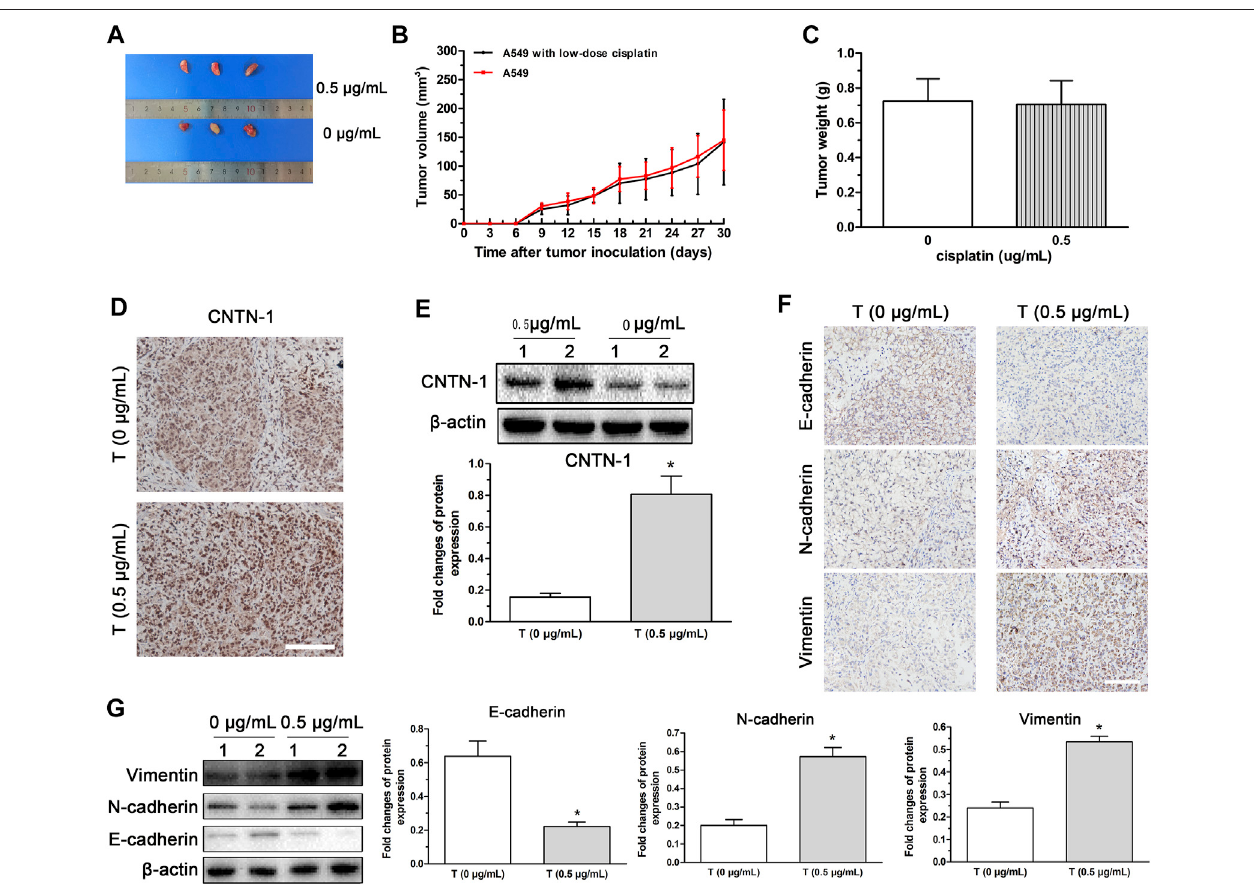
FIGURE6| CNTN -1upregulationandEMTprocessinducedinxenografttumorsdevelopedwithA549cellstreatedwithlow-dosecisplatin. (A) Tumorsdeveloped with A549 cells treated with low-dose cisplatin (0.5 g/mL) and without cisplatin (control), respectively. (B) Growth curves of tumors. No signi fi cant difference in volume was observed between tumors developed with A549 cells treated with low-dose cisplatin (0.5 g/mL) and controls. (C) Tumor weight. No signi fi cant difference of weight was observed between tumors developed by A549 cells treated with low-dose cisplatin (0.5 g/mL) and controls (* p > 0.05). (D – G) CNTN -1 and EMT-related markers(E-cadherin,N-cadherin,andvimentin)oftumorsmeasuredbyWesternblotandimmunohistochemistry,respectively.Both CNTN -1andmesenchymalmarkers (N-cadherin and vimentin) were signi fi cantly upregulated whereas epithelial marker (E-cadherin) was downregulated in the xenograft tumor developed by A549 cells treated with low-dose cisplatin compared with that of controls (* p < 0.05). All pictures were photographed at a magni fi cation of ×100, scale bar = 100 um. Each experiment was conducted in triplicate and the data were expressed as mean ±